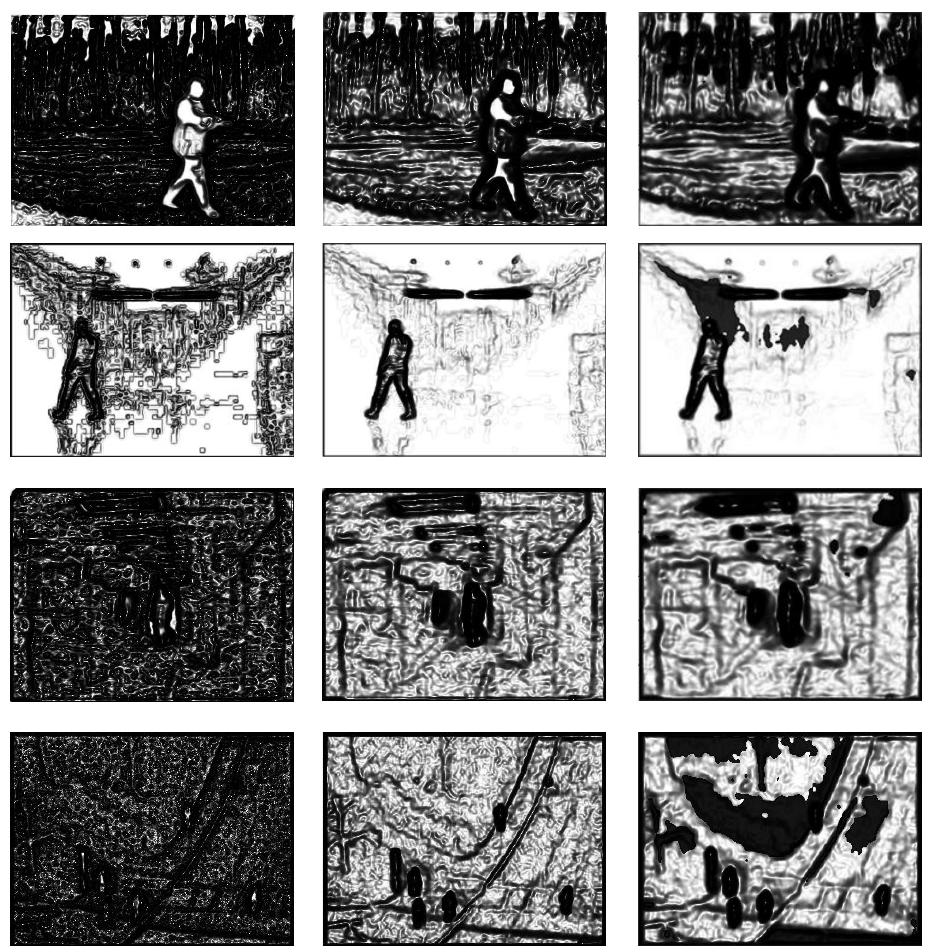
Figure 5. Edge indicator functions are generated with the proposed method ( the first column ); DRLSE ( the second column ); Robust_ESF ( the third column ).